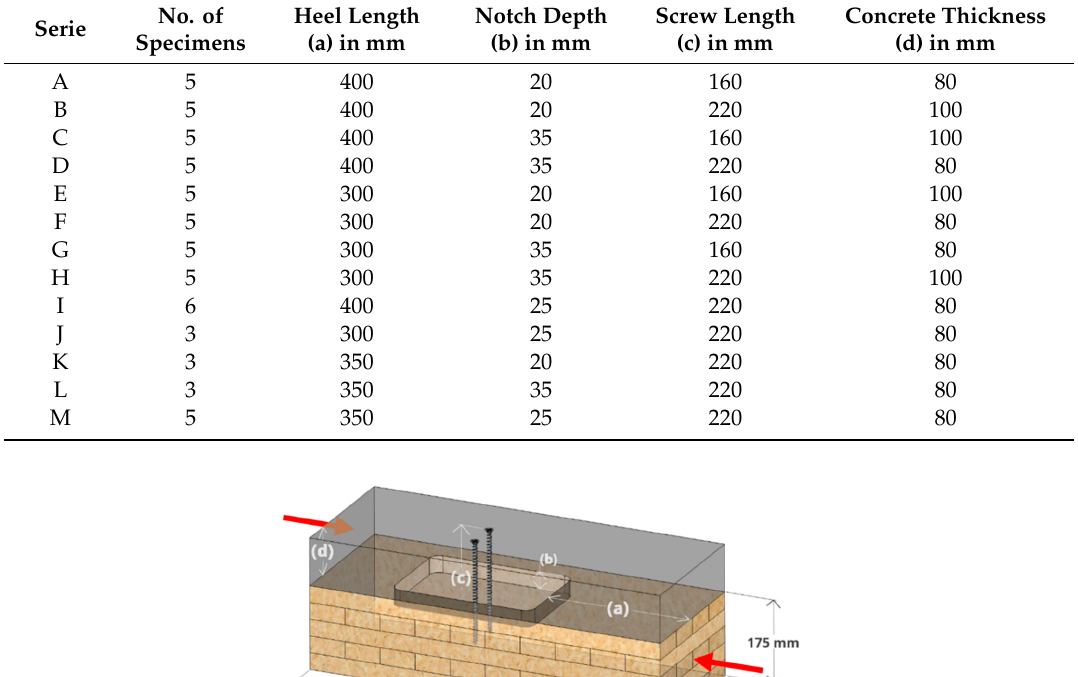
Table 2. Parameters of test series, in mm.